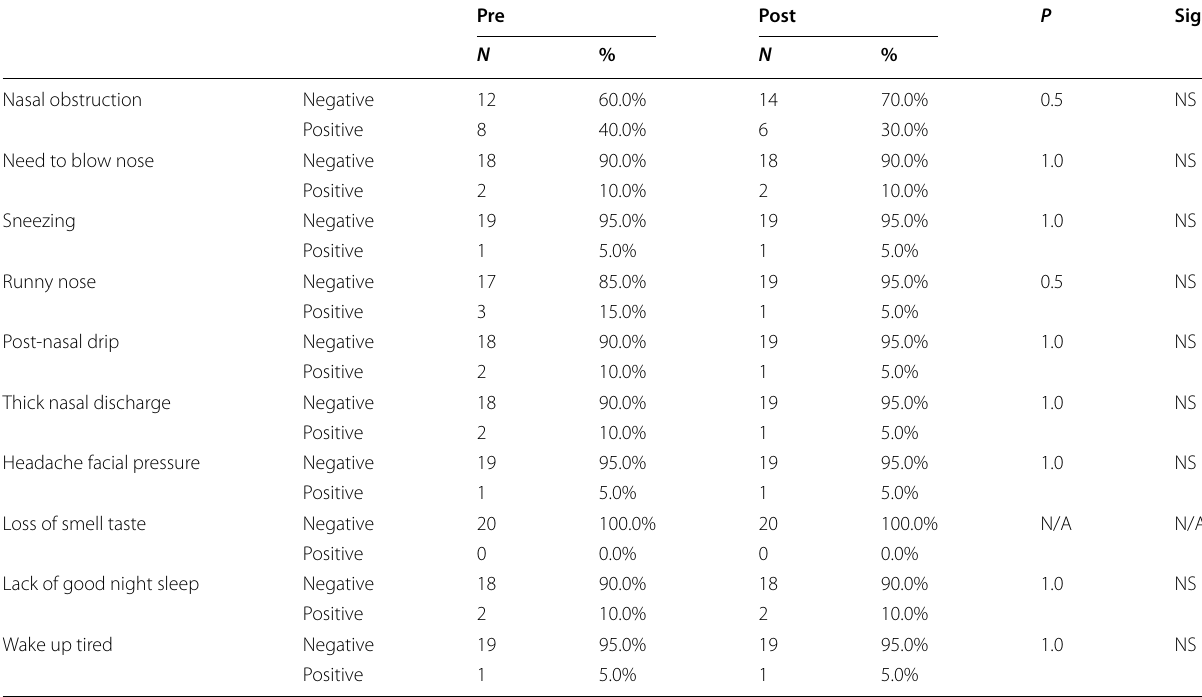
Table 2 Comparison between the pre- and post-SNOT questionnaire of symptoms among control